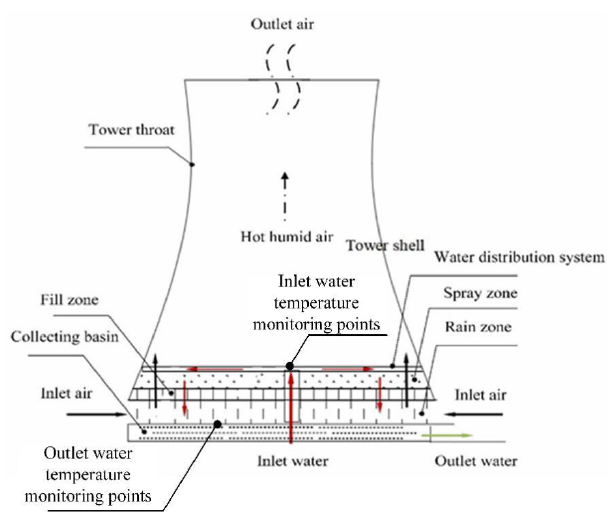
Figure 3. Schematic diagram of NDWCT and the location of monitoring points.